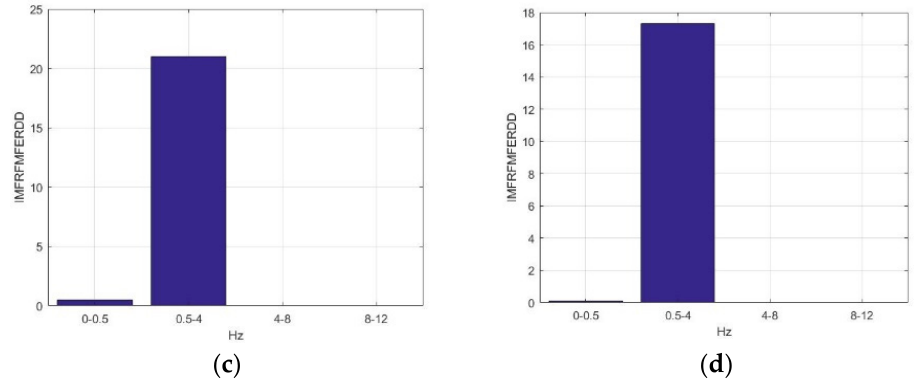
Figure 7. Average IMFRFMFERDD values of IMF4 (MF4) in ILF, delta, theta, and alpha rhythms for F5AM, F5MI, F6AM, and F6MI, respectively. ( a ) average IMFRFMFERDD values (F5AM MF4), ( b ) average IMFRFMFERDD values (F5MI MF4), ( c ) average IMFRFMFERDD values (F6AM MF4), and ( d ) average IMFRFMFERDD values (F6MI MF4).